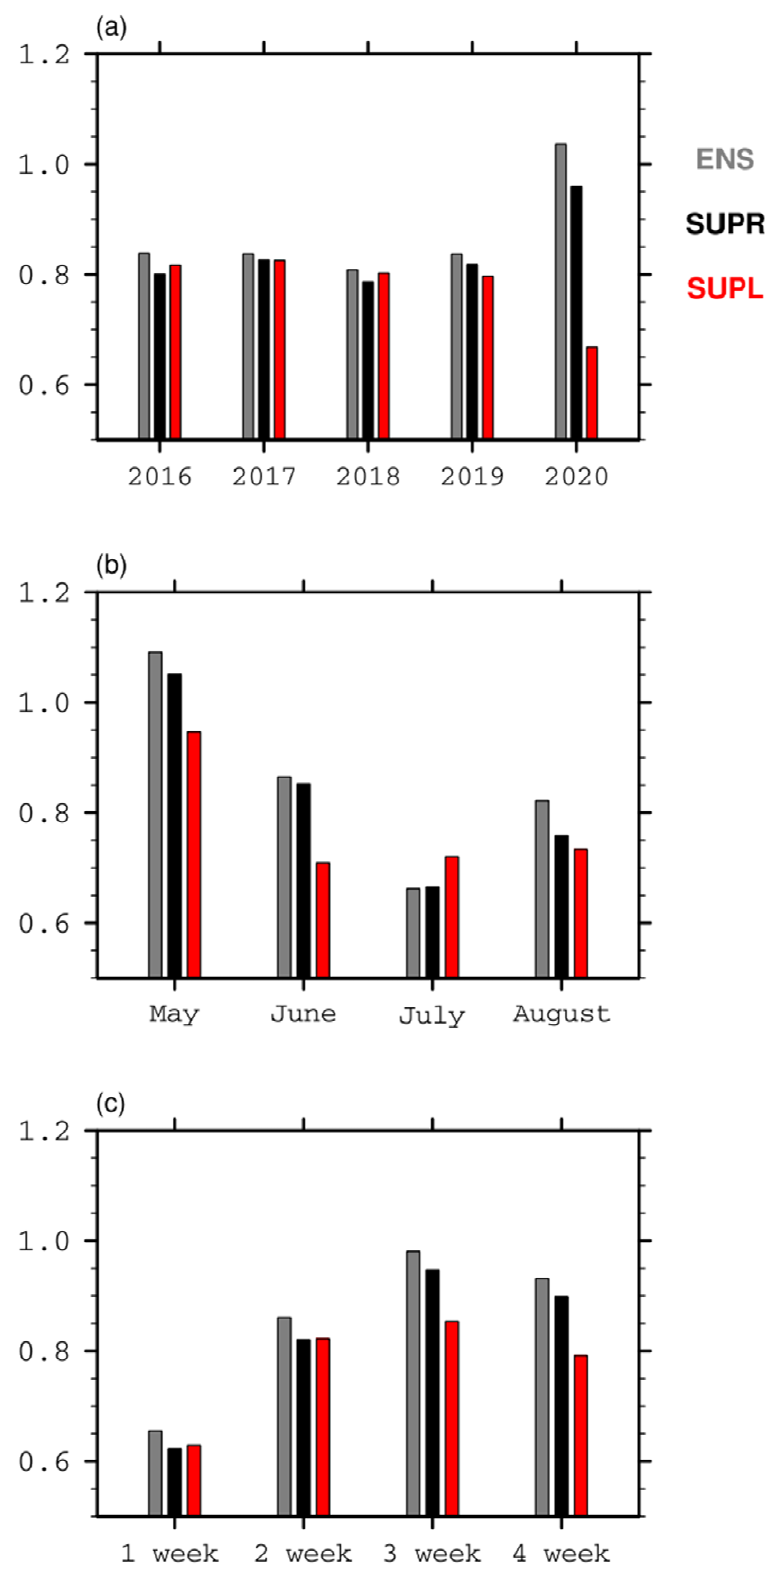
Figure 6. RMSEs of surface air temperature for ENS, SUPR, and SUPL in ( a ) 2016–2020, ( b ) initial month from May to August, and ( c ) forecast time of 1–4 weeks averaged in the area of 25°–50° N, 105°–150° E.